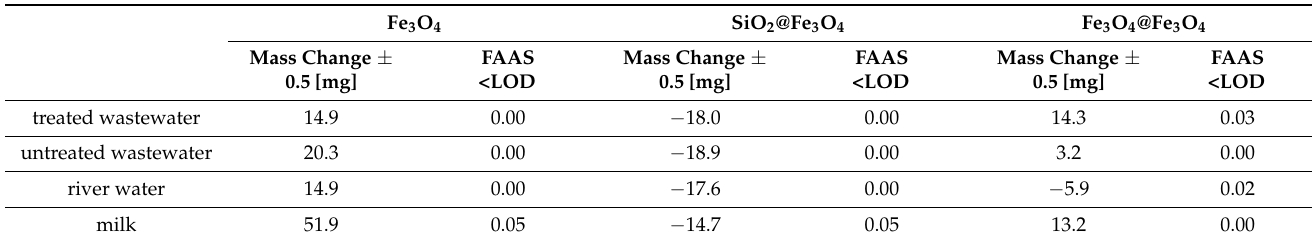
Table 1. A simultaneous presentation of mass changes of the tested nanoparticles before and after 3 weeks wetting, and the Fe amount in the different solutions (LOD-limit of